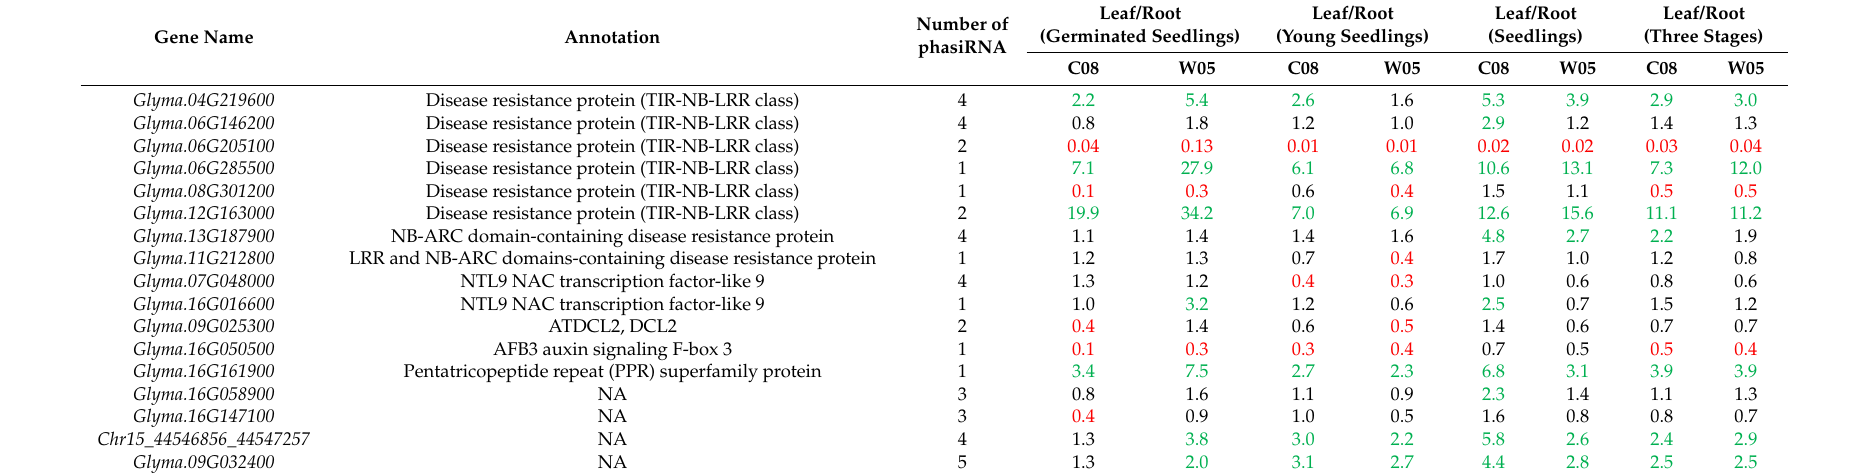
Table 3. Differential amounts of phasiRNAs in the PHAS regions in leaves versus